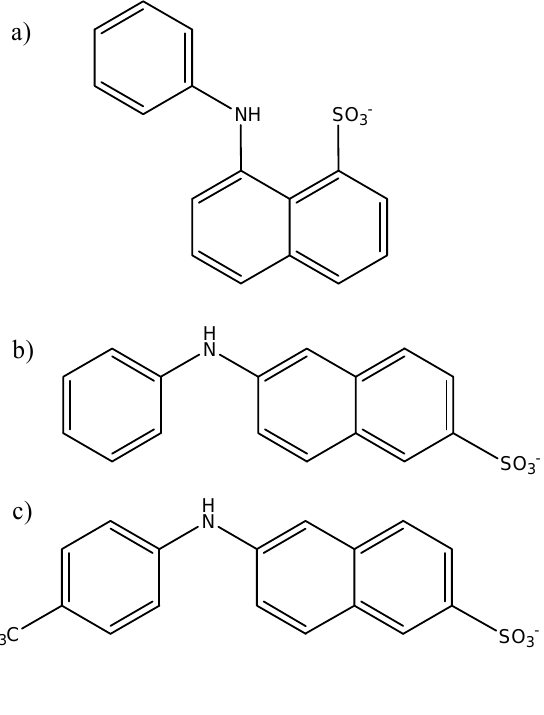
Figure 2. Chemical structure of the three related fluorescent probes used: a) 1,8-ANS; b) 2,6-ANS; c)